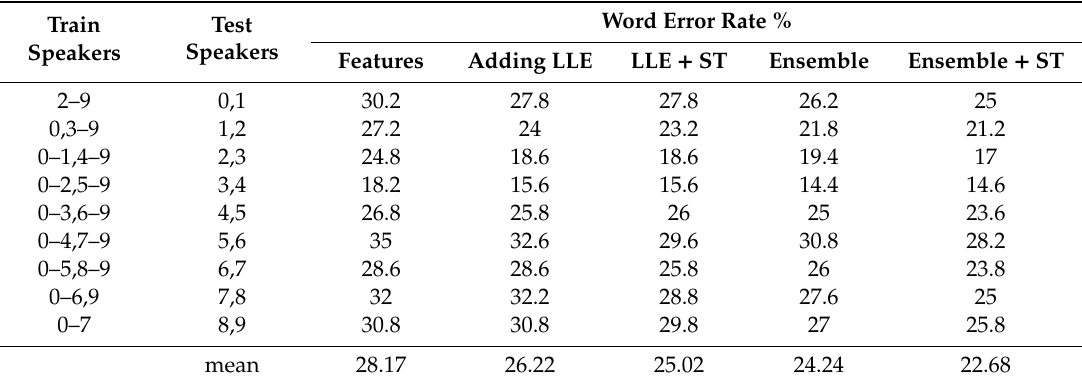
Table 6. Word Error Rate for 20% data as test.